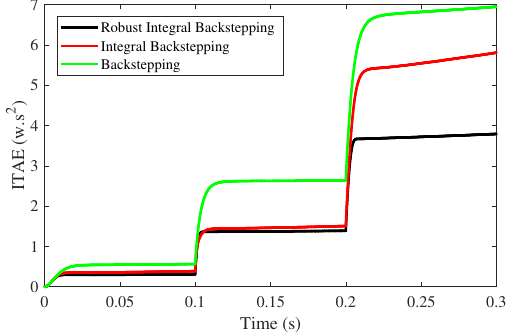
Figure 10. ITAE for varying temperature and